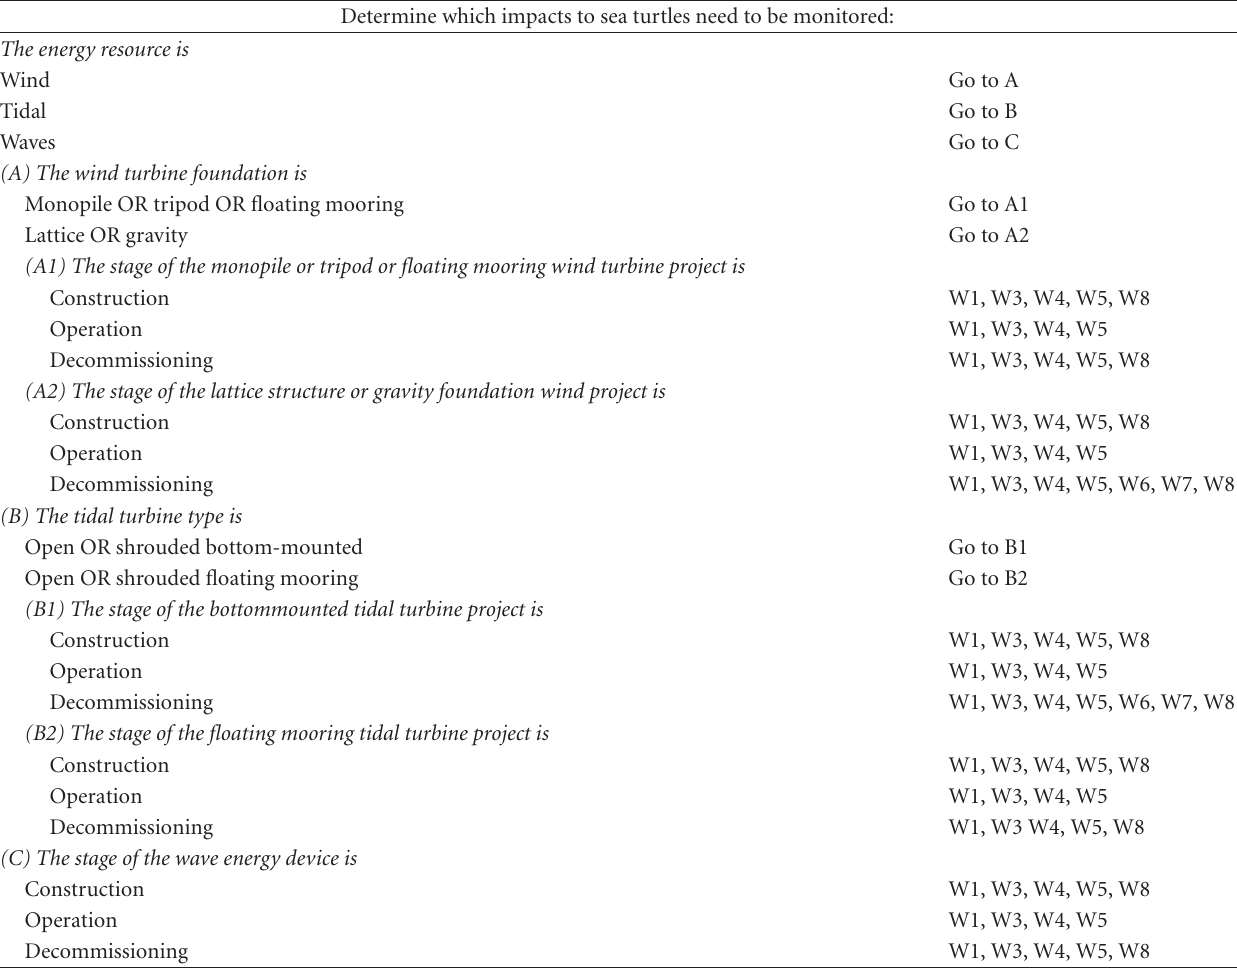
Table 13: Component decision tree for impacts on sea turtles. The key is followed to obtain a recommended suite of monitoring protocols. Determine which impacts to sea turtles need to be